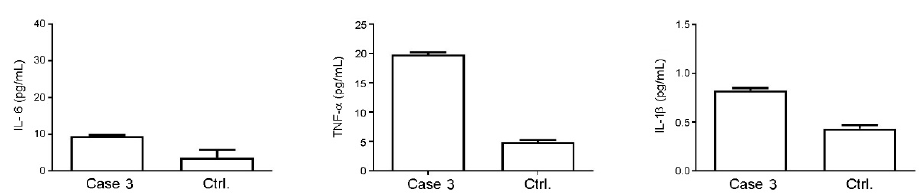
Figure 5. Analysis of levels of IL-6, TNF- α and IL-1 β in the serum of Case 3 compared to control donors. Values are expressed as pg/mL.